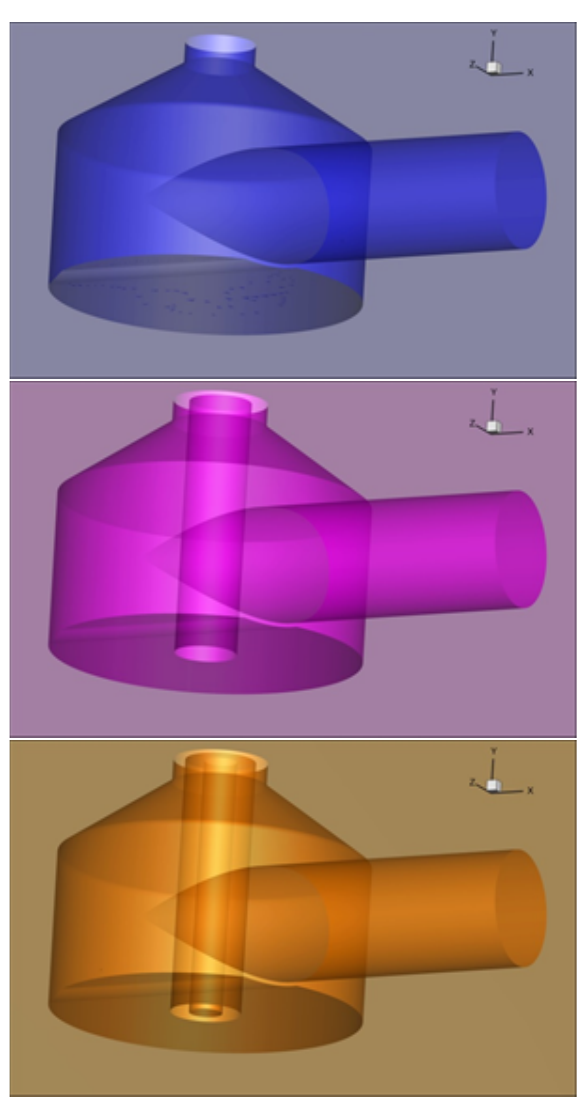
Fig. 1. Geometry from the top: T0t, T1t and T2t for zero angle of tangential input .